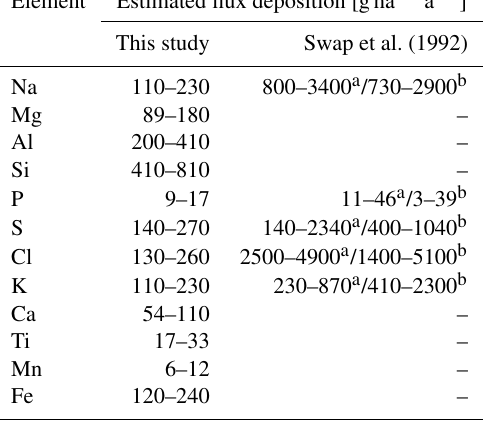
Table 4. Estimated annual deposition of LRT-related elements in the ATTO region. The results are based on the modeled total dust aerosol deposition of 5–10kgha − 1 a − 1 as discussed in Sect. 3.3 in combination with the EDXRF results in Fig. 14. Note that these numbers represent only the part of the dust deposition gradient in Fig. 7 that includes the ATTO site (yellow area). For comparison, el- emental deposition flux reported by Swap et al. (1992) are reported as